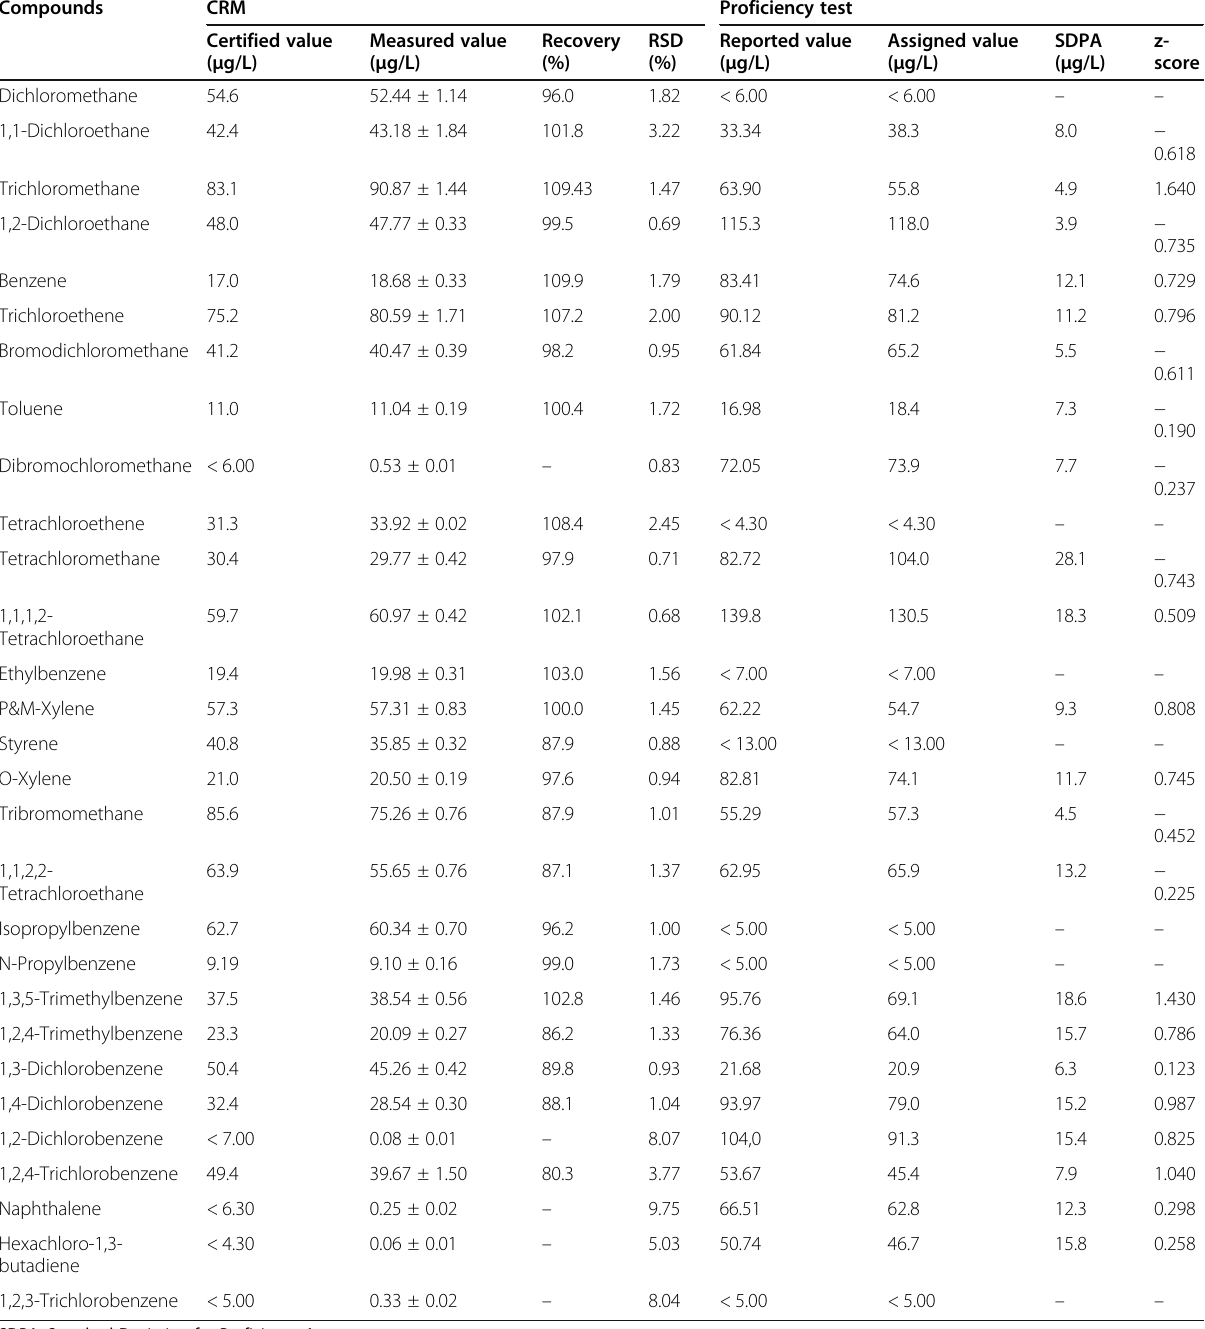
Table 4 CRM and inter-laboratory test results for VOCs Compounds CRM Proficiency test